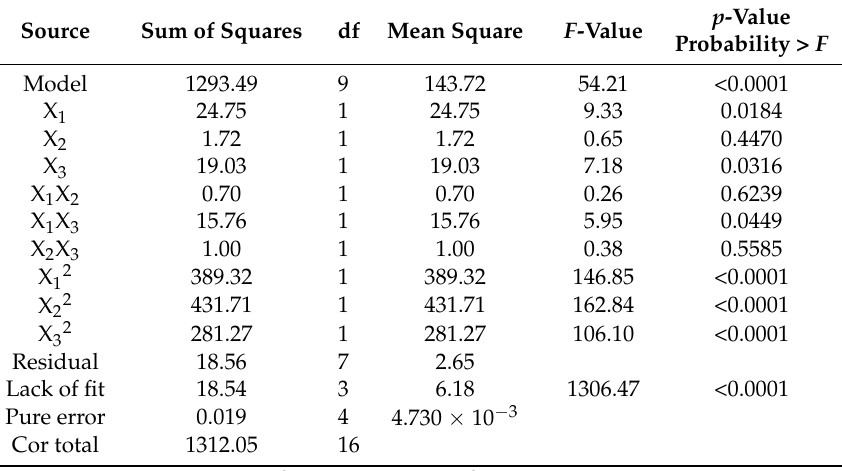
Table 2. ANOVA results of the quadratic